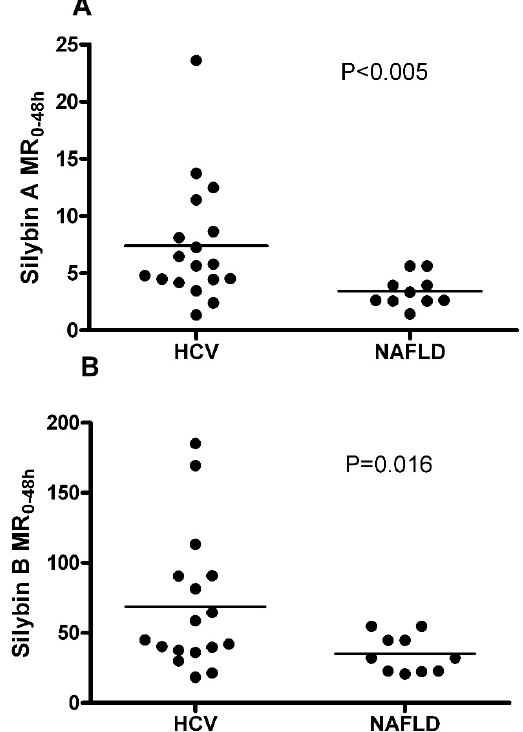
Figure 2. Silybin ( A , B ) metabolic ratio (MR) stratified by liver disease type. Mean MR in